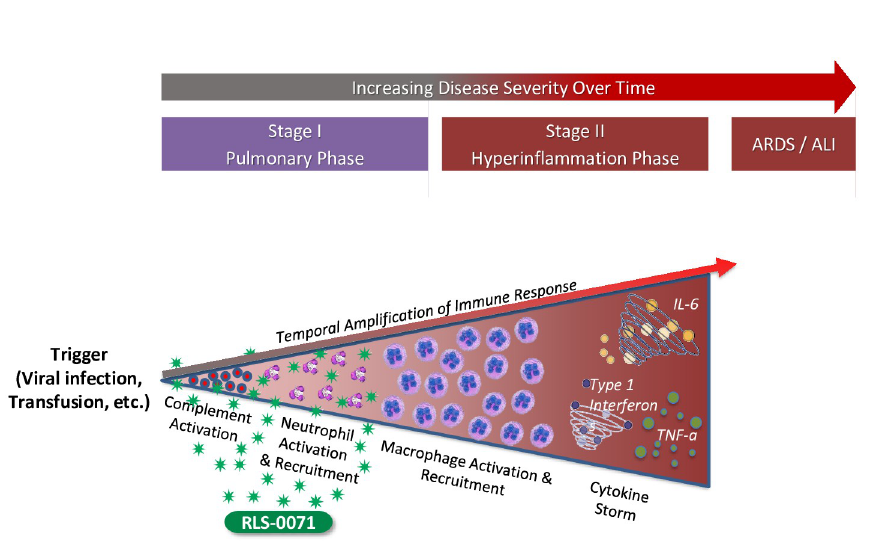
Fig 8. RLS-0071 inhibits ALI at the earliest stage of immune dysregulation. ALI ensues following triggering of the humoral (complement cascade) and cellular (neutrophil) innate immune response. RLS-0071, as illustrated by the green stars, downregulates both these processes by acting on the earliest stages of the inflammatory cascade preventing escalation of the cytokine storm and tissue damage.